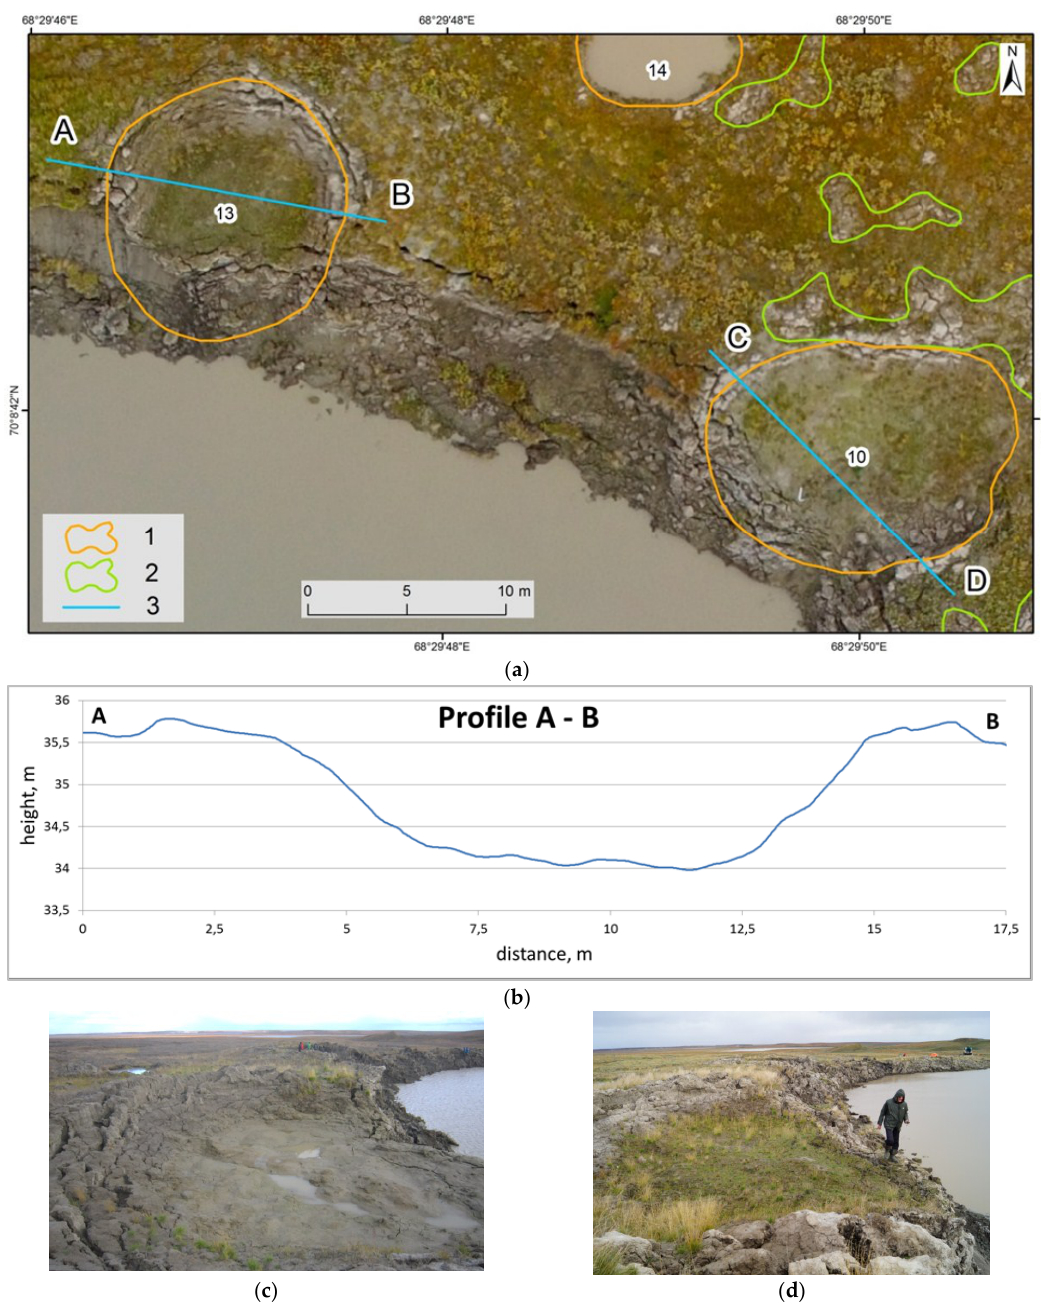
Figure 5. Morphological and morphometric characteristics of impact water-filled hollows at GEC-2: ( a ) boundaries of impact hollows 13 and 10, and hypsometric profiles plotted on the orthophotomap of 2017. Legend: 1, impact hollows; 2, areas with numerous piles; 3, position of hypsometric profiles; ( b ) hypsometric profile across impact hollow 13 plotted on digital elevation model (DEM) of 2017; ( c ) hollow 13 drained by 2015 (photograph by A. I. Kizyakov, September 2015); ( d ) overgrowth of the bottom of hollow 13 by pioneer vegetation in 2017 (photograph by E. A. Babkina, September 2017).